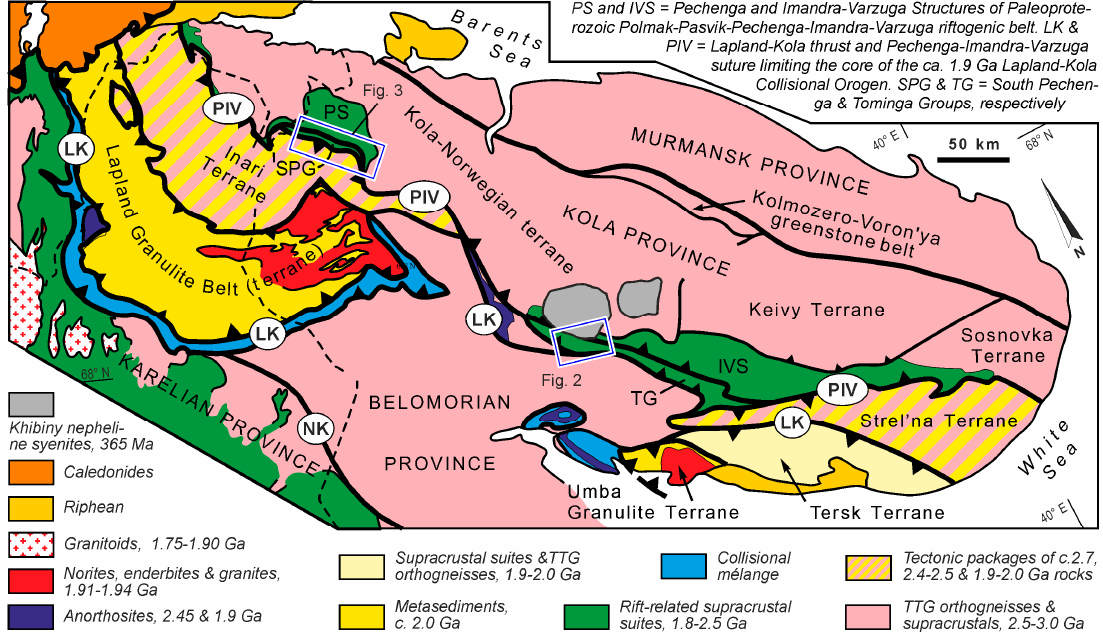
Figure 1. Tectonic map of the northern Fennoscandian Shield (modified from [19,20]).